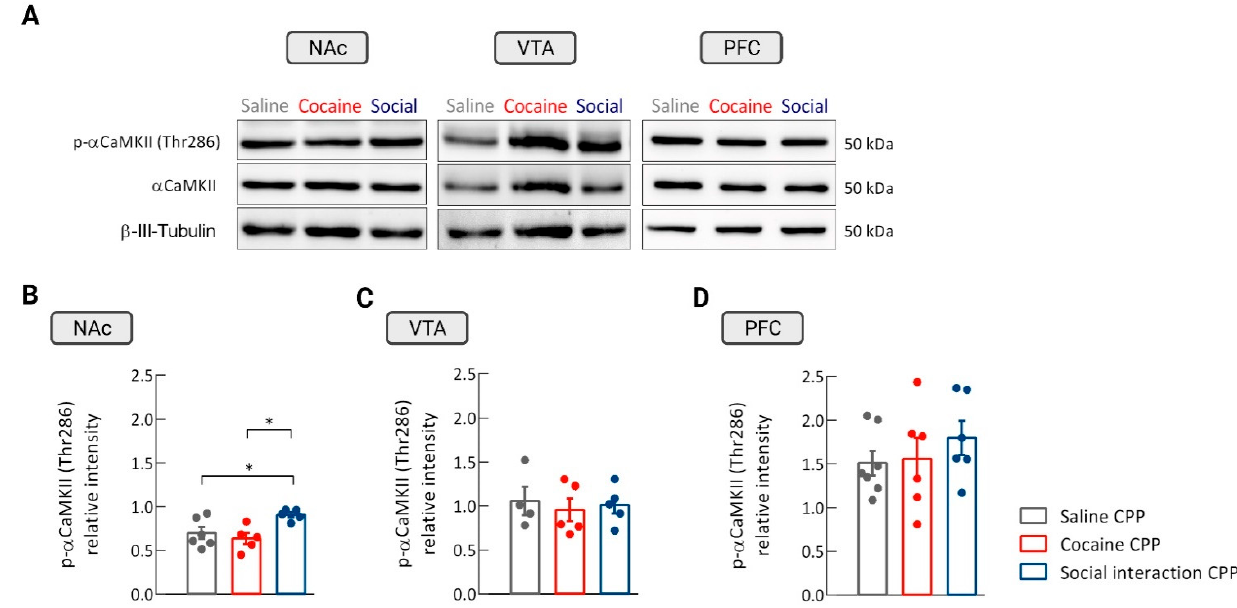
Figure 2. α CaMKII phosphorylation levels in the nucleus accumbens (NAc), ventral tegmental area (VTA), and prefrontal cortex (PFC) after cocaine and social interaction CPP. ( A ) Representative western blot images of phosphorylated α -CaMKII (p- α CaMKII) (Thr286), α CaMKII, and β -III-Tubulin levels (used as protein loading control) in the NAc, VTA, and PFC of rats from the saline, cocaine, and social interaction CPP groups. ( B ) Relative intensity of NAc α CaMKII phosphorylation at Thr286 in rats that expressed saline, cocaine, and social interaction CPP. * p < 0.05, one-way ANOVA followed by Newman–Keuls multiple comparisons test; n = 5–6. ( C ) Relative intensity of the bands that express p- α CaMKII levels in the VTA of rats from the cocaine and social interaction CPP groups, as well as the control group—saline CPP; p = non-significant (ns), n = 4–5. ( D ) Relative intensity of the bands that express p- α CaMKII levels in the PFC of rats that expressed cocaine and social interaction CPP, and the control group—saline CPP; p = ns; n = 6–7. Results are presented as mean ± SEM.